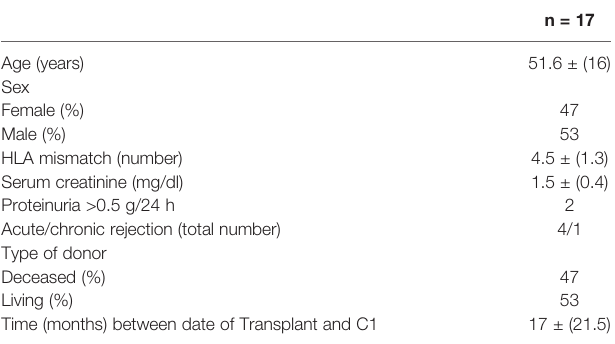
TABLE 1 | Demographic data of the 17 patients from whom ASTRLs were expanded.